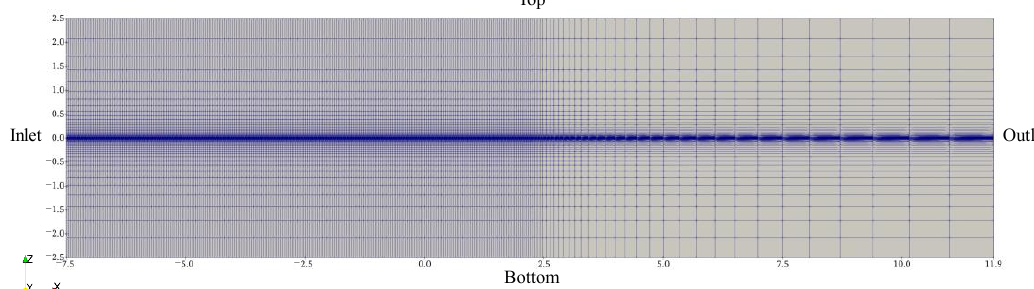
Figure 2. Domain extent and boundary condition of the regular wave simulation.